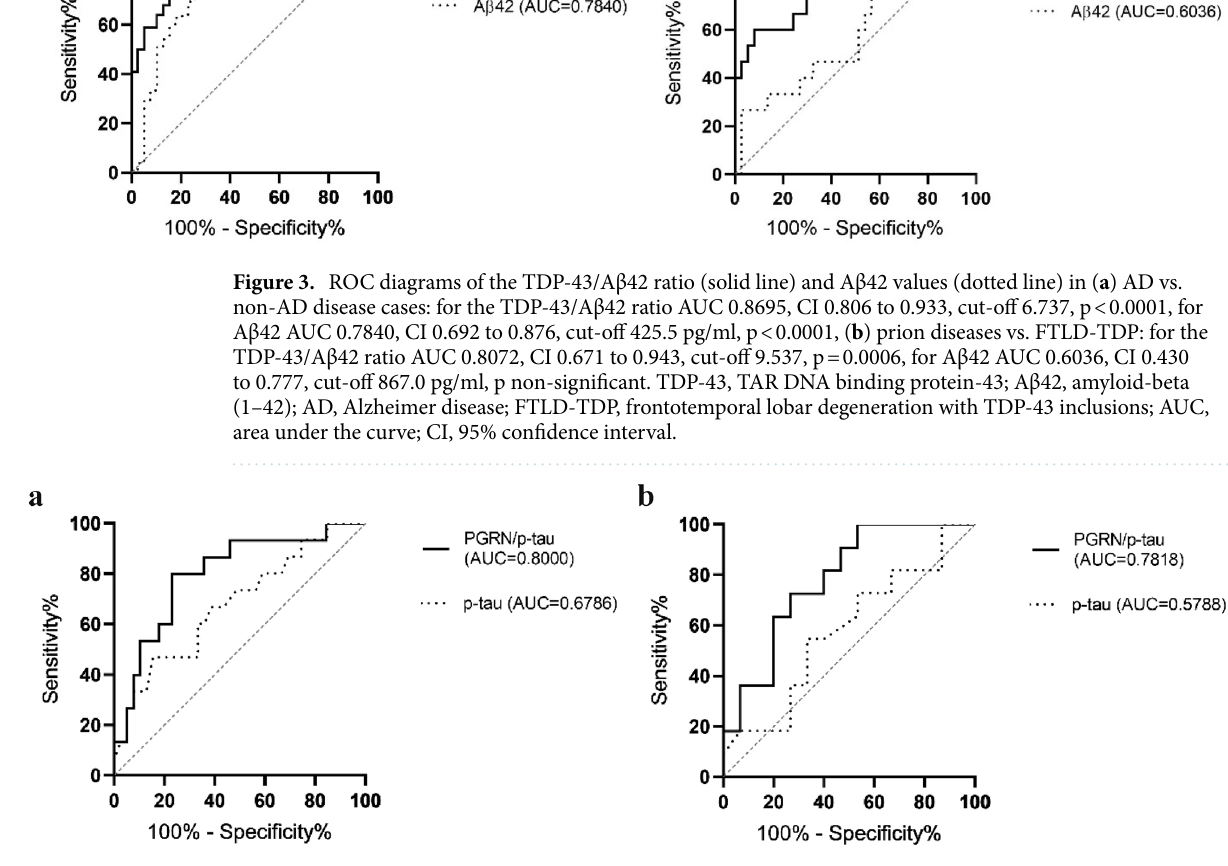
Figure 4. ROC diagrams of the PGRN/p-tau ratio (solid line) and p-tau values (dotted line) in ( a ) AD vs. FTLD-tau: for the PGRN/p-tau ratio AUC 0.8000, CI 0.668 to 0.933, cut-off 92.1, p = 0.0007, for p-tau AUC 0.6786, CI 0.517 to 0.841, cut-off 36.0 pg/ml, p = 0.0436, ( b ) FTLD-tau vs. DLB: for the PGRN/p-tau ratio AUC 0.7818, CI 0.606 to 0.958, cut-off 137.6, p = 0.0158, for p-tau AUC 0.5788, CI 0.352 to 0.805, cut-off 50.5 pg/ml, p non-significant. PGRN, progranulin; p-tau, phosphorylated-tau (181P); AD, Alzheimer disease; FTLD-tau, frontotemporal lobar degeneration with tau inclusions; DLB, dementia with Lewy bodies; AUC, area under the curve; CI, 95% confidence interval.